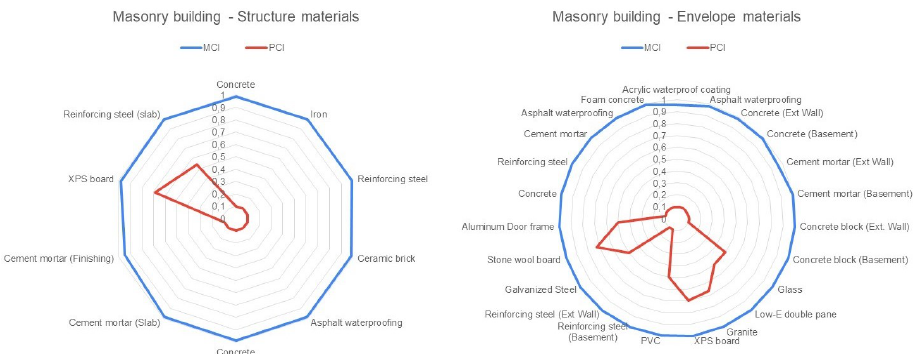
Figure 2. MCI and PCI results – Concrete-framed & masonry building.